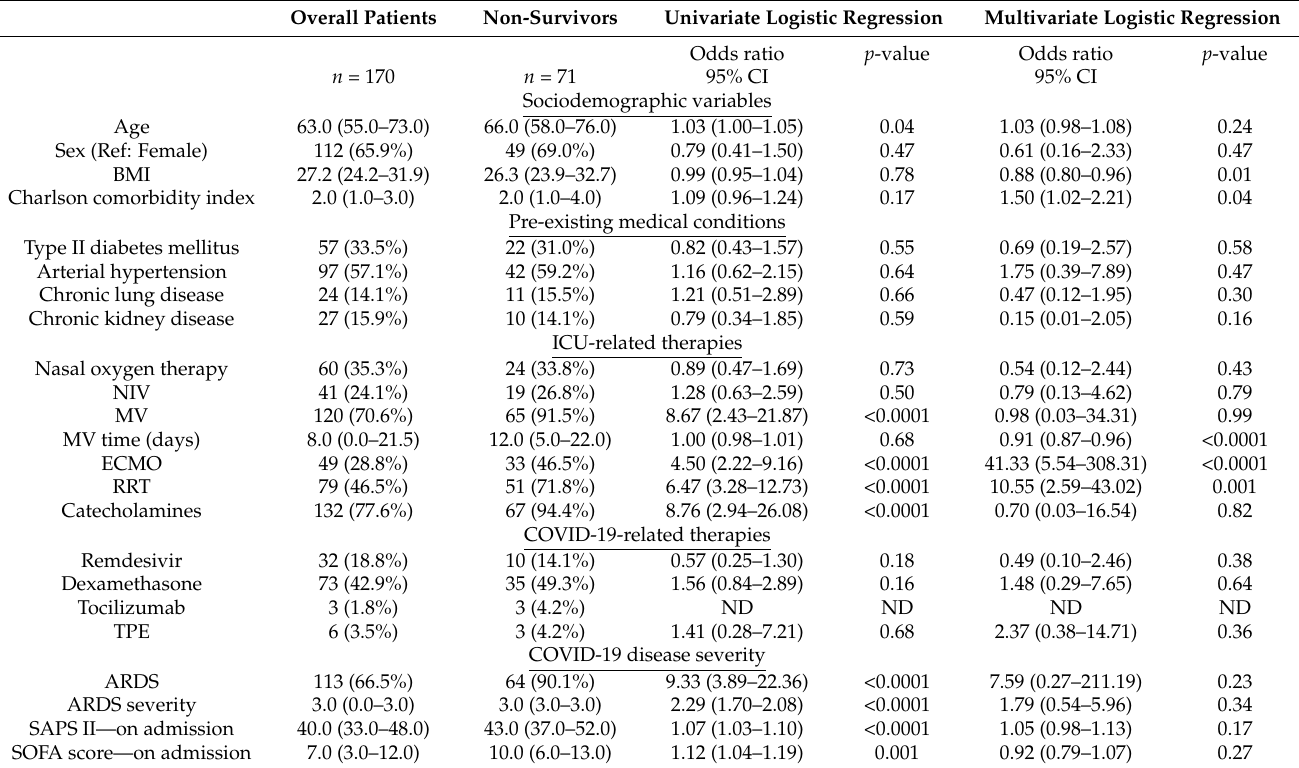
Table 2. Baseline characteristics of consecutive COVID-19 patients admitted to the Department of Intensive Care Medicine (University Medical Center Hamburg-Eppendorf, Germany) are illustrated ( n = 170). Patients were grouped according to their overall survival. Numbers with frequencies and median with interquartile ranges are illustrated. Univariate and multivariate logistic regressions were performed. Odds ratios with 95% confidence intervals are given. Model estimators: Wald chi-square test: 64.96, p < 0.0001; Akaike’s information criterion (AIC): 140.73. Abbreviations: BMI, body mass index; ICU, intensive care unit; NIV, noninvasive ventilation; MV, mechanical ventilation; ECMO, extracorporeal membrane oxygenation; RRT, renal replacement therapy; COVID-19, coronavirus disease 2019; TPE, therapeutic plasma exchange; ARDS, acute respiratory distress syndrome; SAPS II, simplified acute physiology score 2; SOFA, sepsis-related organ failure assessment